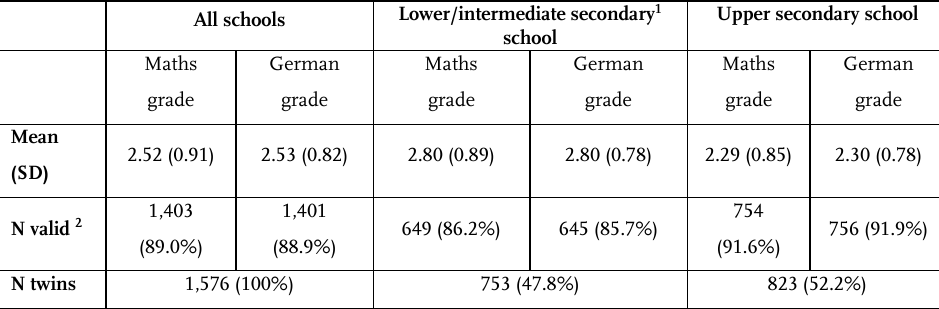
Table 2 : Descriptive statistics on school grades and track attendance (analytical sample) Upper secondary school All schools Lower/intermediate secondary 1 school Maths Maths grade grade